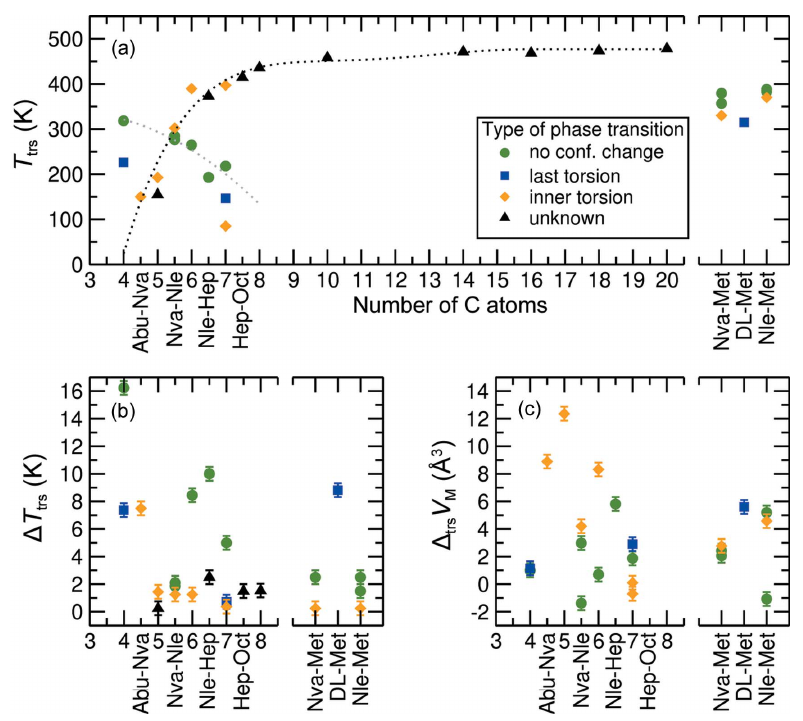
Figure 5 Characteristics of the solid-state phase transitions of linear-chain racemic and quasi-racemic amino acids: ( a ) transition temperatures of the racemates up to a chain length of 20 carbon atoms, and quasi-racemates up to a chain length of 8 carbon atoms; ( b ) hysteresis; and ( c ) transition volume changes versus the number of carbon atoms per molecule. The dotted lines are guides to the eye. For the quasi-racemates (all with (cid:2) n = 1) the average chain length was used, i.e. 5.5 for d -Nva- l -Nle. All structures involving Met are on the right-hand side of the